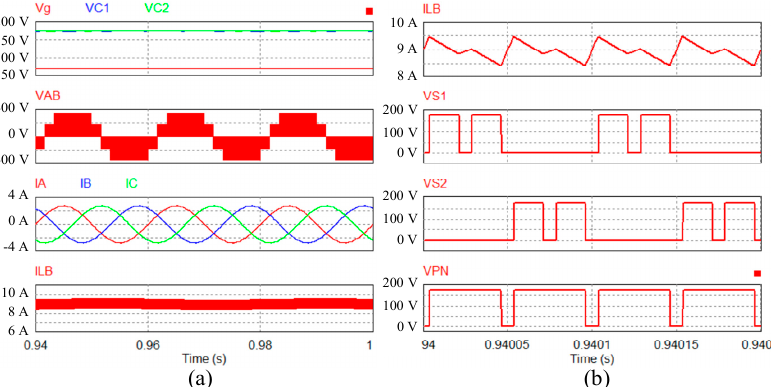
Figure 9. The simulation results of the proposed method when V g = 70 V. From top to bottom: ( a ) input voltage ( V g ), capacitor voltage ( V C 1 , V C 2 ), line-to-line voltage ( V AB ), load current ( I A , I B , I C ), inductor current ( I LB ), ( b ) zoom in of inductor current ( I LB ), impedance switch voltages ( V S1 , V S2 ), DC-link voltage ( V PN ).